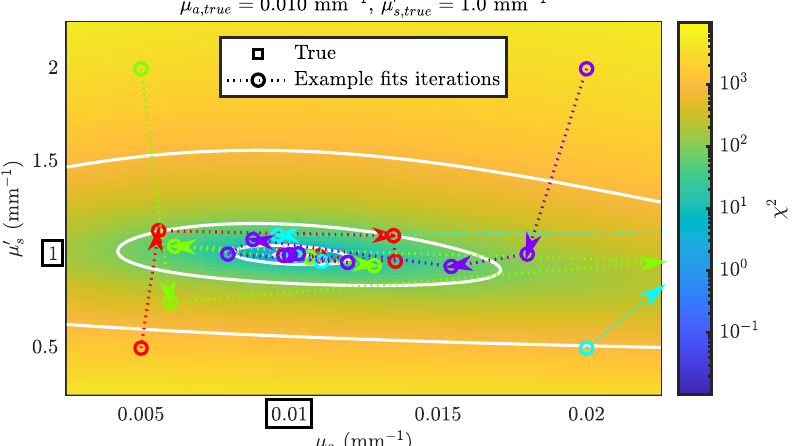
Figure 7. Example trajectories of fmincon minimization of χ 2 (Equation (28); κ = 1.2 × 10 − 3 ) to fit = 0.005mm − 1 & for the µ a and the µ (cid:48) s . Results from 4 different initial guess es shown: ( Red ) µ a , guess = 0.5mm − 1 . ( Green ) µ a = 0.005mm − 1 & µ (cid:48) = 2.0mm − 1 . ( Cyan ) µ a = µ (cid:48) s s , guess , guess , guess , guess = 0.5mm − 1 . ( Purple ) µ a = 2.0mm − 1 . = 0.020mm − 1 & µ (cid:48) 0.020mm − 1 & µ (cid:48) s s , guess , guess , guess Acronyms and Symbols: Cost ( χ 2 ), scaling factor ( κ ), absorption coefficient ( µ a ), and reduced scatter- ing coefficient ( µ (cid:48) s